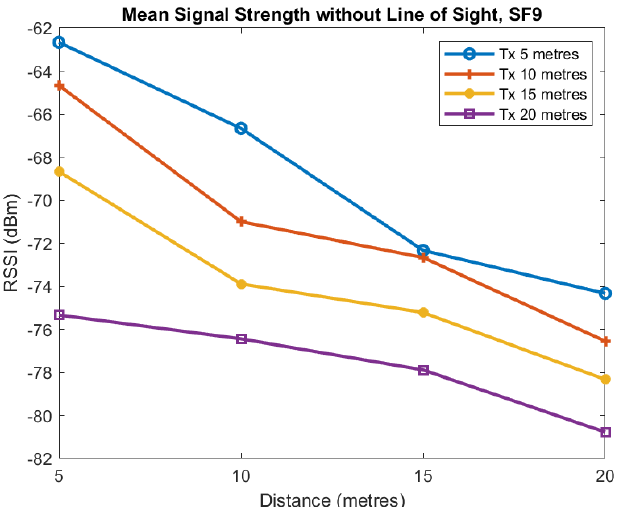
Figure 16. Mean RSSI against receiver distance from junction for different transmitter distances from junction, SF9.